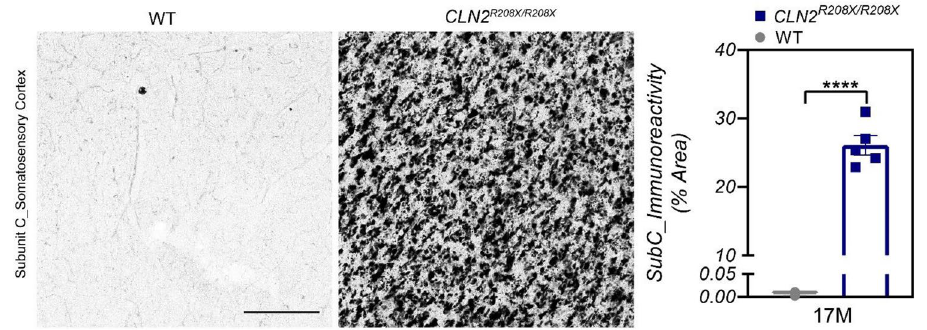
Figure 7. Mitochondrial ATP synthase subunit c accumulates in the somatosensory cortex of CLN2 R208X/R208X animals. Subunit c accumulation shown in the somatosensory cortex at 17-months-of-age. Mean ± SEM, Nested t-test. ****p < 0.0001. Scale bar = 200